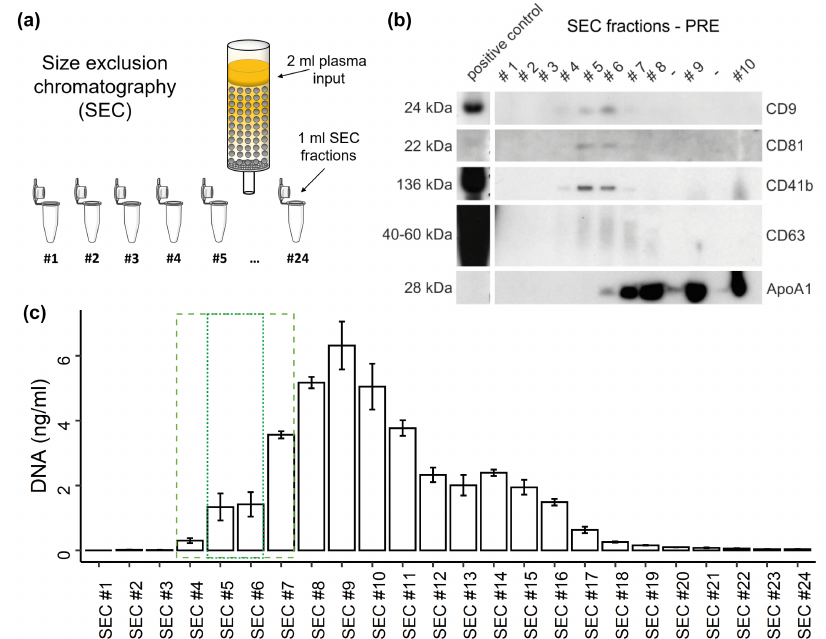
Figure 1. Distribution of extracellular vesicles (EVs) and DNA in SEC fractions. ( a ) Illustration of size exclusion chromatography (SEC) of plasma. ( b ) Western blot (WB) analysis of specific SEC fractions using genuine EV-markers including CD9, CD81, and CD63, as well as platelet specific marker CD41b, and lipoprotein marker ApoA1. ( c ) Concentration of DNA in SEC fractions measured by qPCR. The error bars represent SD of three technical qPCR replicates. The dashed box indicates SEC fractions containing EVs. The dotted box highlights most EV rich fractions.